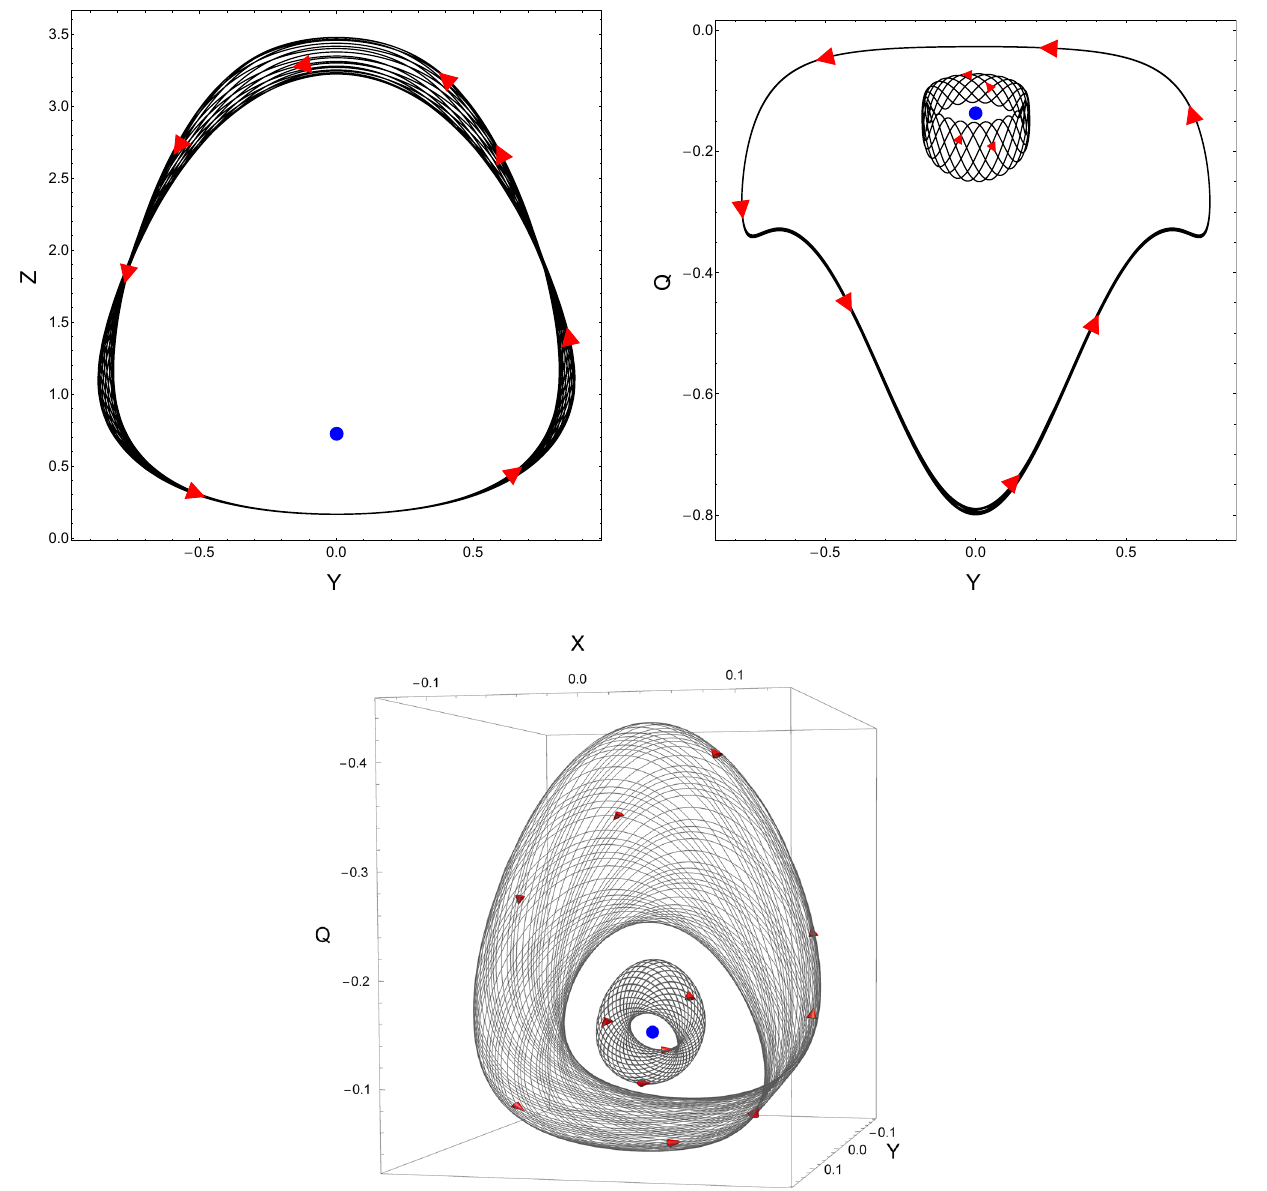
Fig. 5 Dynamical evolution of the Universe dominated by radiation (γ = 4 ) . The initial values for numerical integration of the system 3 (49)–(52) along with model parameters have been set as, ω = − 2, r = − 10, X 0 = Y 0 = 0, Z 0 = 3 . 11, Q 0 = − 0 . 5 (left panel) and Z 0 = 3 . 01, Q 0 = − 0 . 8 for outer orbits and Z 0 = 1 . 012, Q 0 = − 0 . 152 for outer orbits of the right panel. The location of fixed points are given